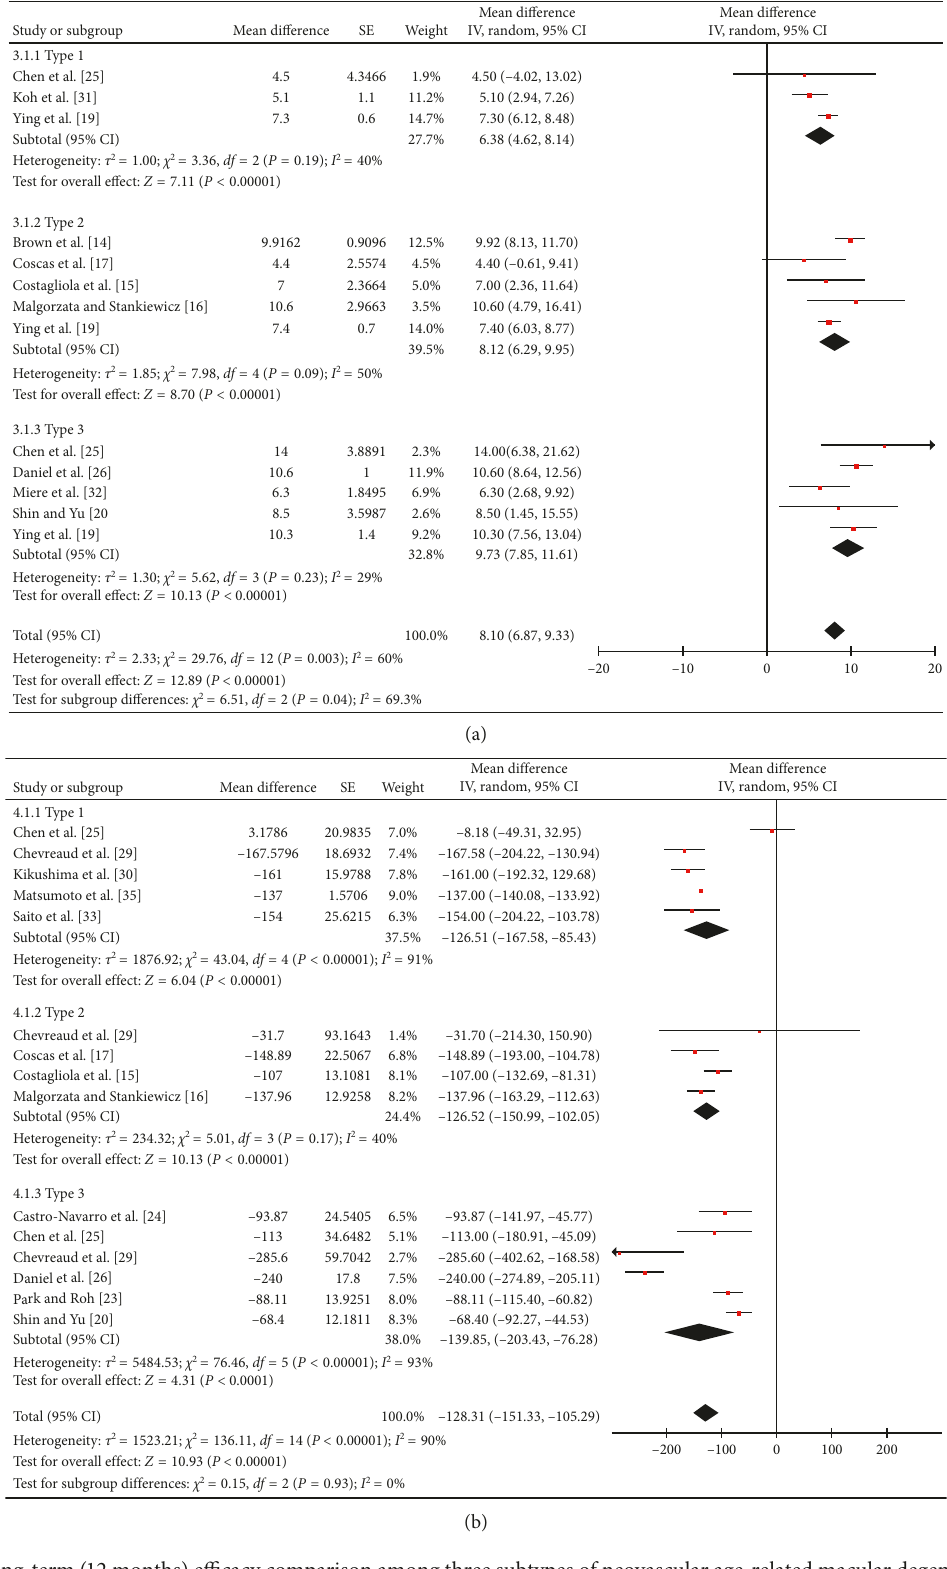
Figure 4: The long-term (12 months) efficacy comparison among three subtypes of neovascular age-related macular degeneration (nAMD) was presented. (a) Vision improvement, evaluated by Early Treatment of Diabetic Retinopathy Study (ETDRS) letters, were 6.38 (95%